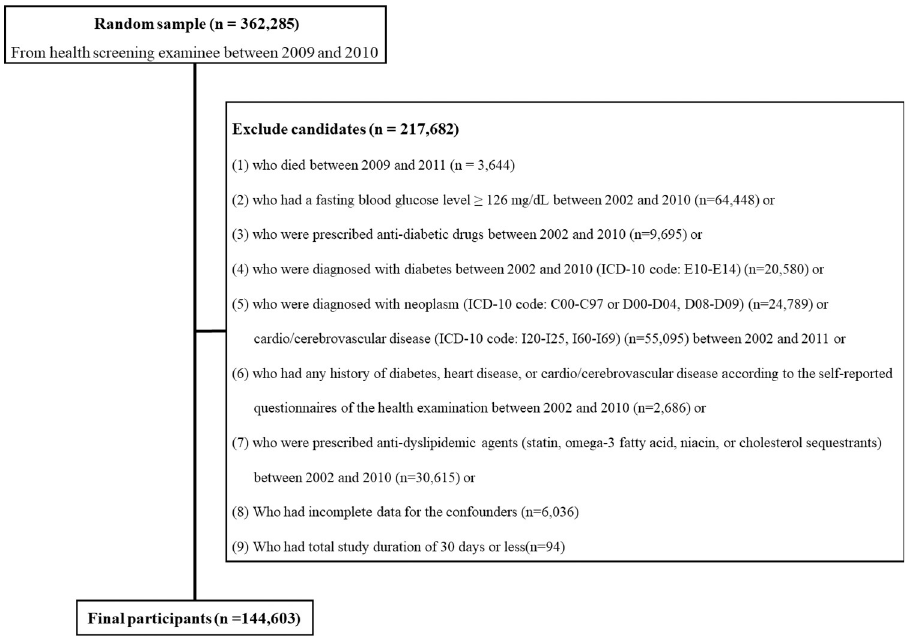
Fig 1. Flowchart of inclusion and exclusion